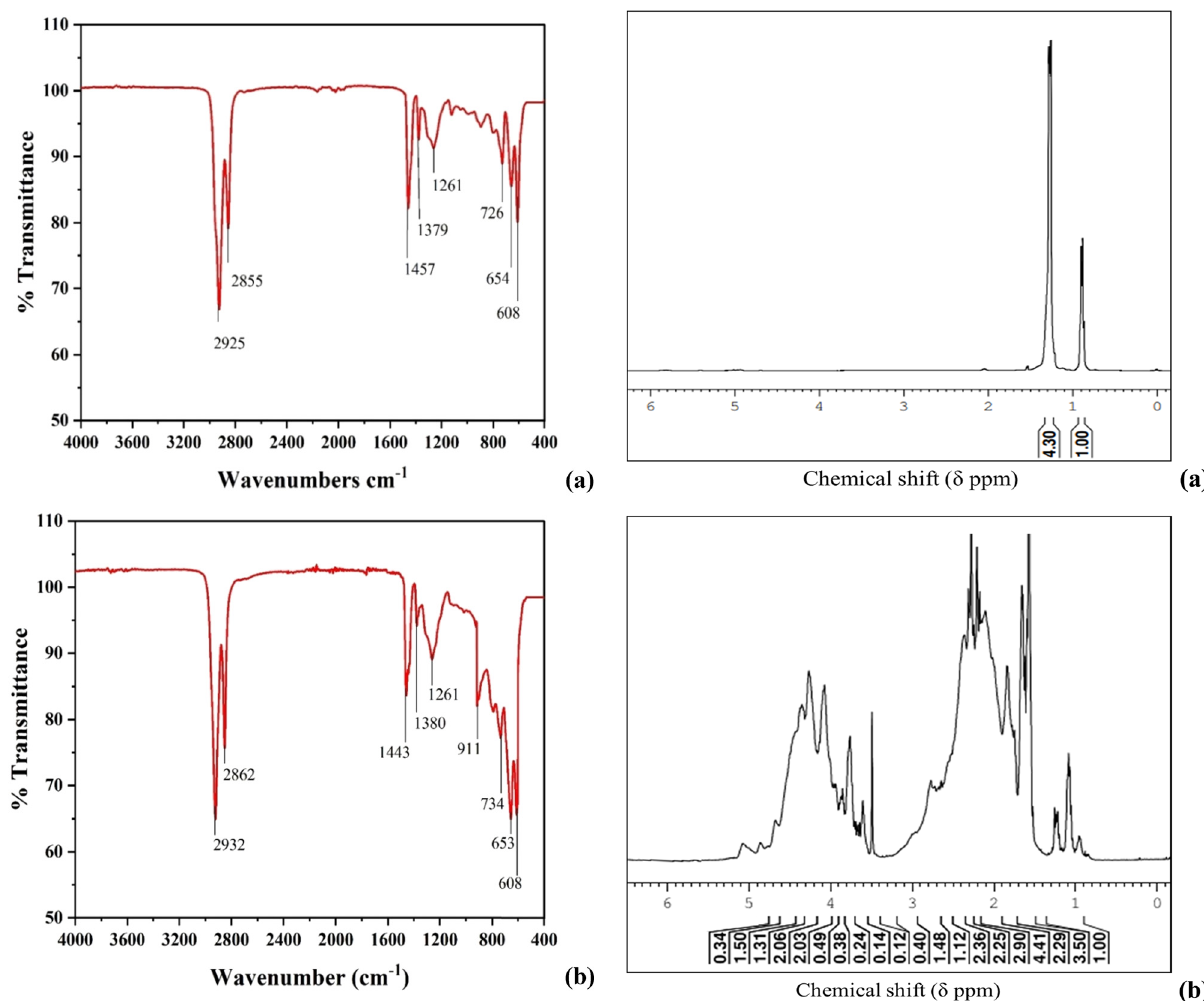
Figure 6: ( a ) FTIR spectrum of chlorinated LDPE post separation; ( b ) FTIR spectrum of co - chlorinated para ffi n post separation from LDPE ( 130°C, chlorine fl ow rate 350 mL · min − 1 , 10% LDPE concen - tration, and 400 rpm )